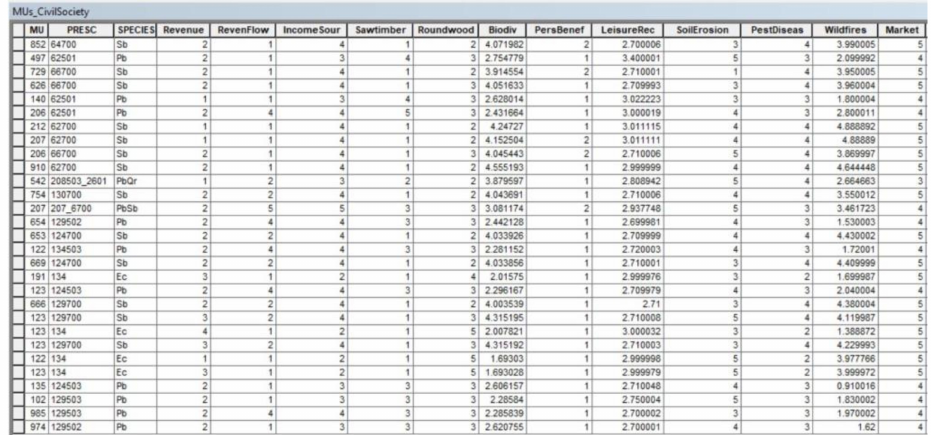
Figure 4. Example of a normalized management units Pareto frontier solution database from 1 (very poor) to 5 (very